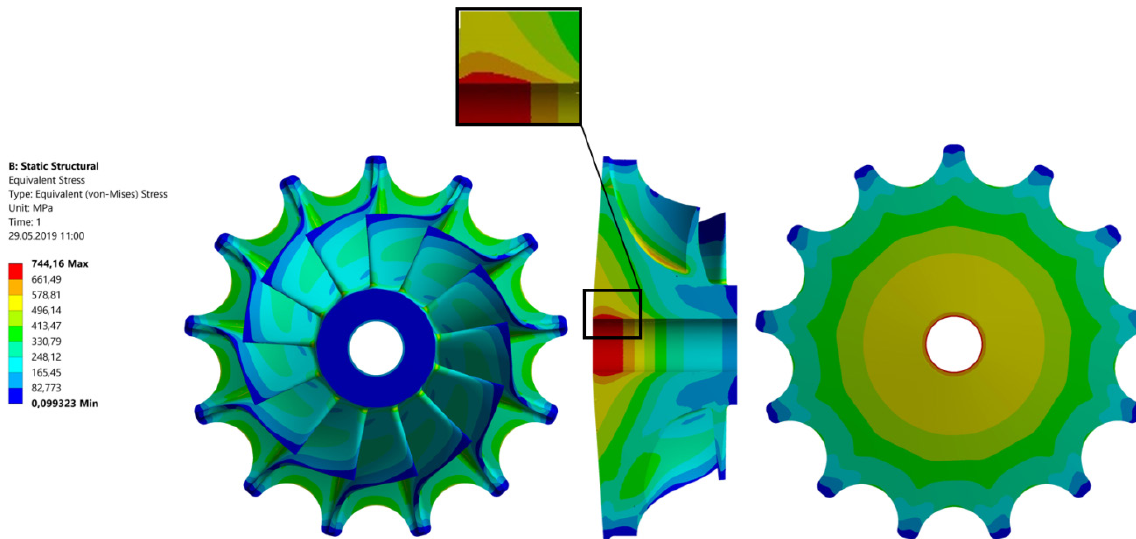
Figure 18: Front, side and rear view of turbine disc - optimisation 2 (rotational speed – 96,000 rpm; temperature – 600 ∘ C)